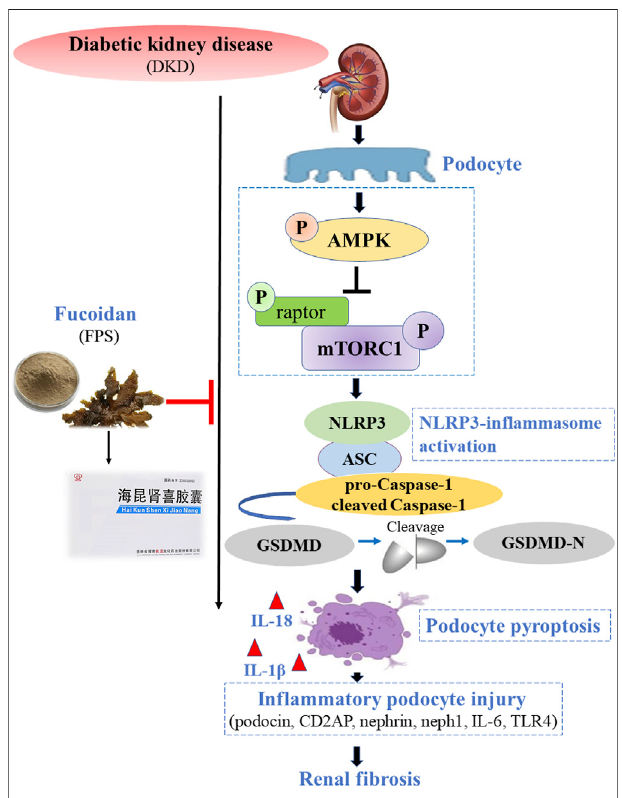
FIGURE15| OverviewoftheeffectsofFPSonRFinDKDviainhibitionof NLRP3 in fl ammasome-mediated podocyte pyroptosis.